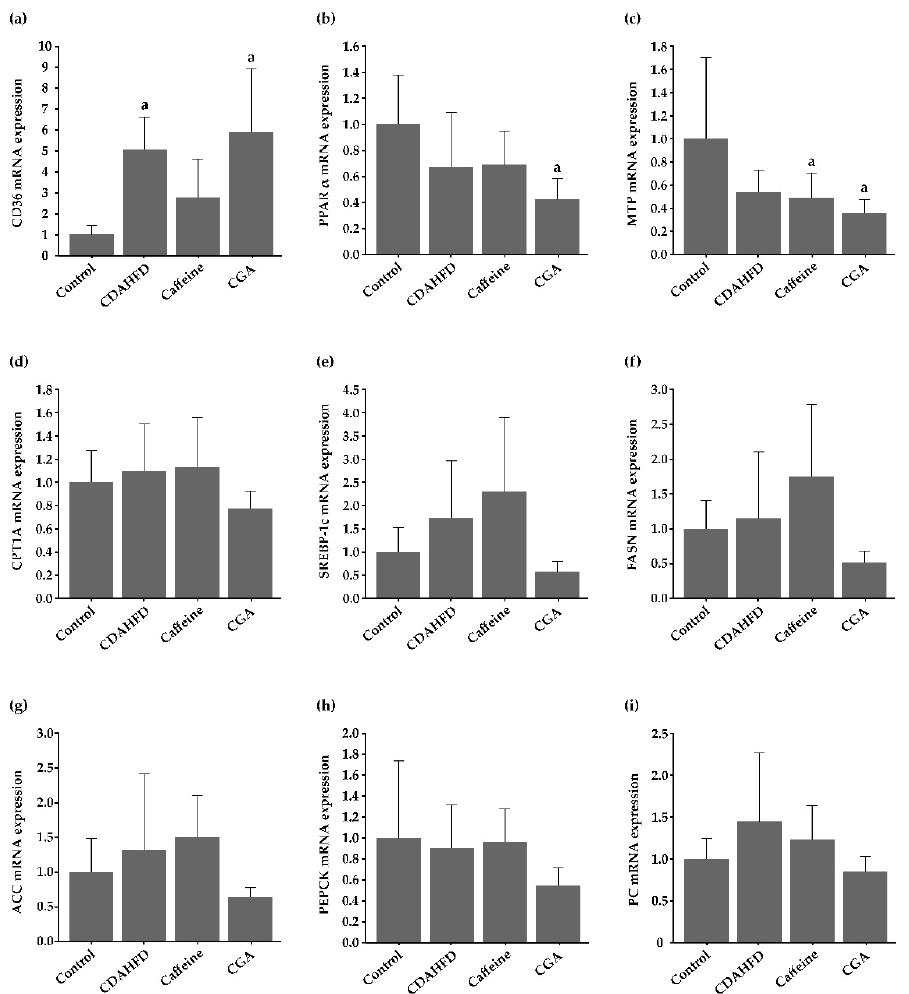
Figure 5. Expression of genes that are associated with lipidic and glucidic metabolism in the liver, determined by real-time RT-PCR ( a – i ). ( a ) Significantly more CD36 is expressed in the livers of